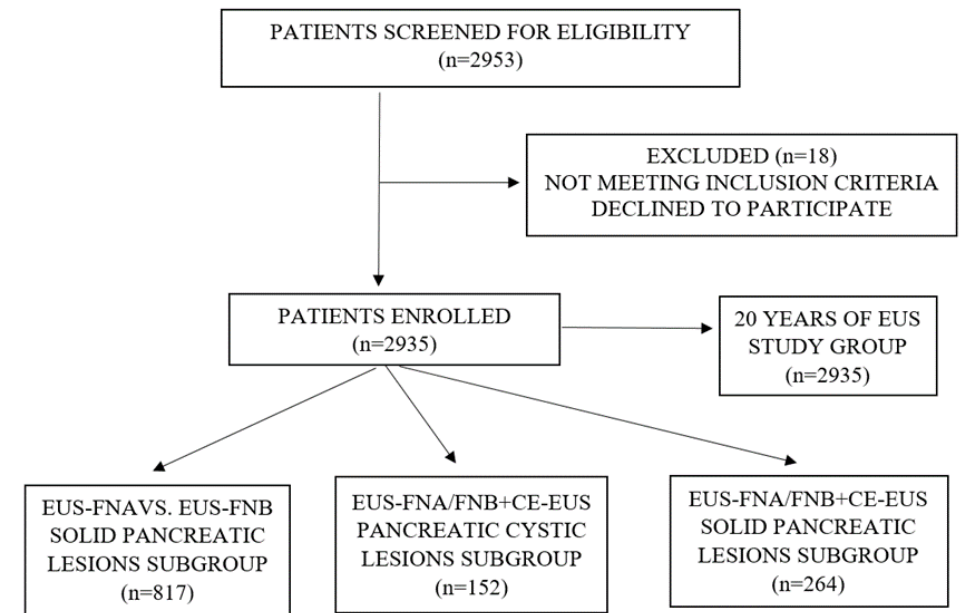
Figure 1. Study Figure 1. Study design.